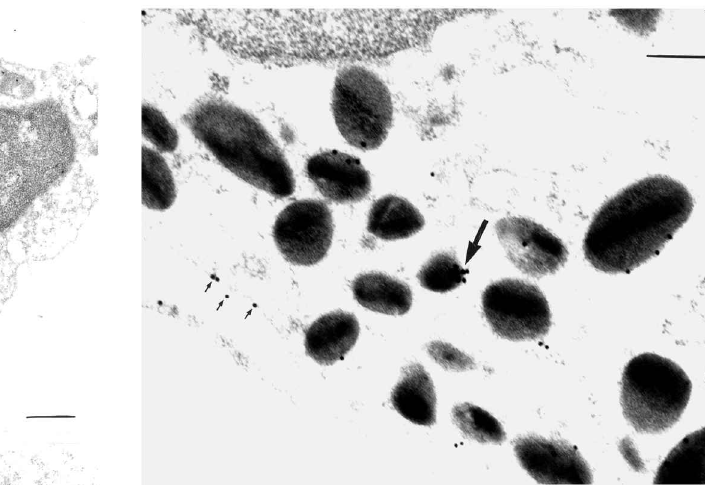
FIG. 3. ANXA1 protein expression in rat mesenteric eosino- phils: LCS3 immunostaining. Treatment was as in Fig. 2, and endogenous ANXA1 immunoreactivity in an extravasated eosinophil was detected with LCS3. Gold particles are clearly evident both in granules (large arrow) as well as in cyto- plasmic vacuoles (small arrows). Bar: 0.5 m